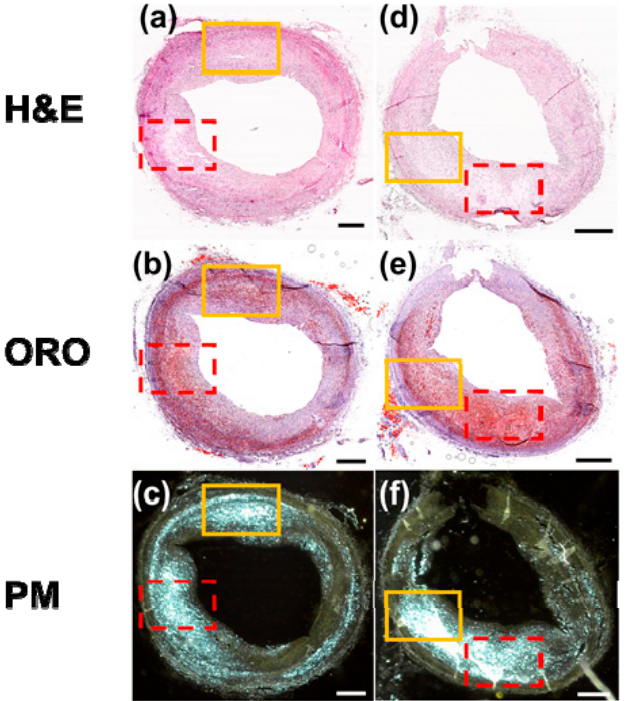
Figure 7. Microscopic images of artery sample with a relatively early stage of atheroma stained with ( a , d ) H&E and ( b , e ) ORO and ( c , f ) PM images of unstained samples. All scale bars: 500 μ m.